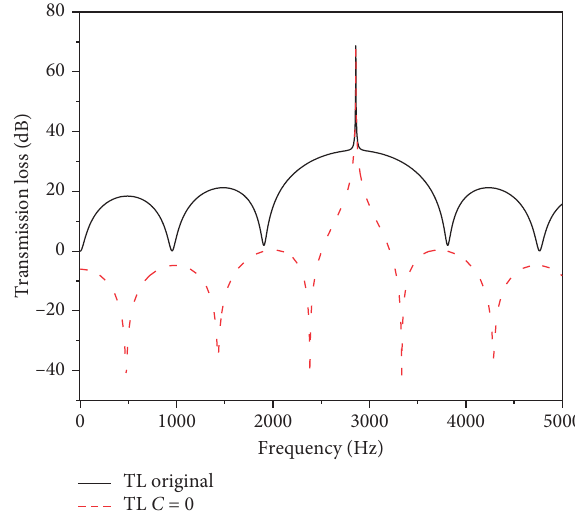
Figure 3: Quadrupole parameter analysis of the side outlet muffler ( A � 0).